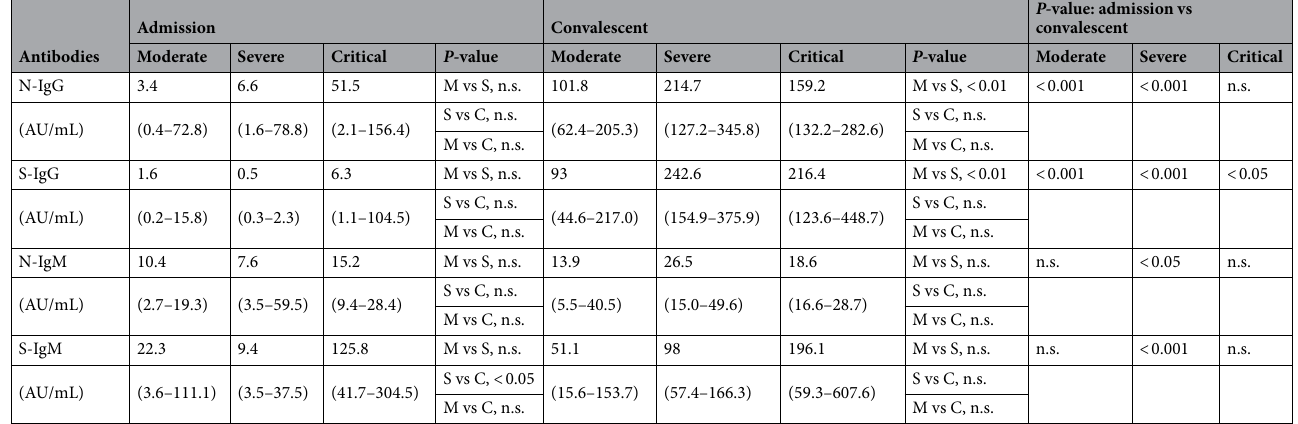
Table 1. Changes in IgG and IgM antibodies in response to the presence of SARS-CoV-2 antigen during hospital admission and convalescence. Antibody concentrations are expressed as medians (distribution range). P -values were obtained by Mann–Whitney U test and Steel–Dwass test. C critical, M moderate, S severe, n.s. not significant.